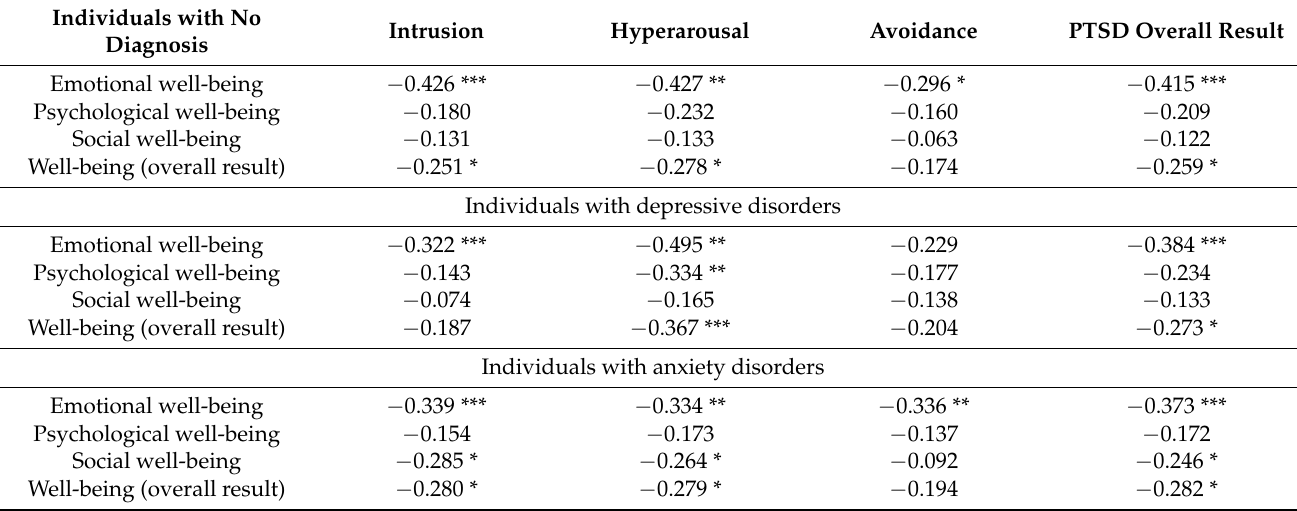
Table 6. Pearson correlation coefficients between well-being and PTSD symptoms ( n = 70 in each